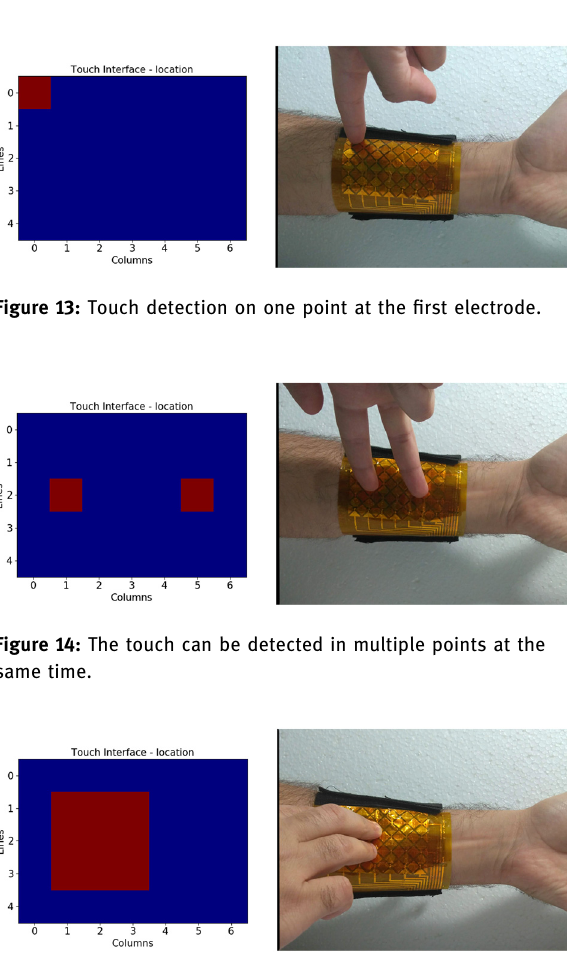
Figure 15: A touch in an area is also possible of being detected.